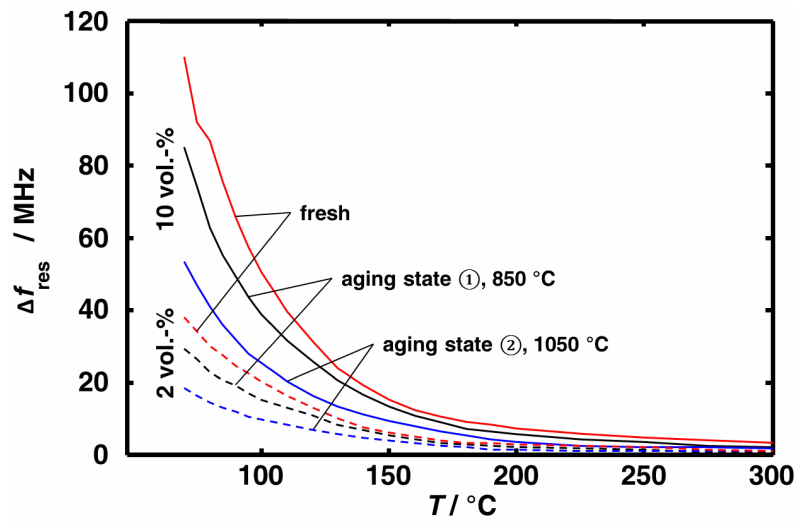
Figure 6. Temperature dependent resonance frequency differences to water-free feed gas compositions for all three aging